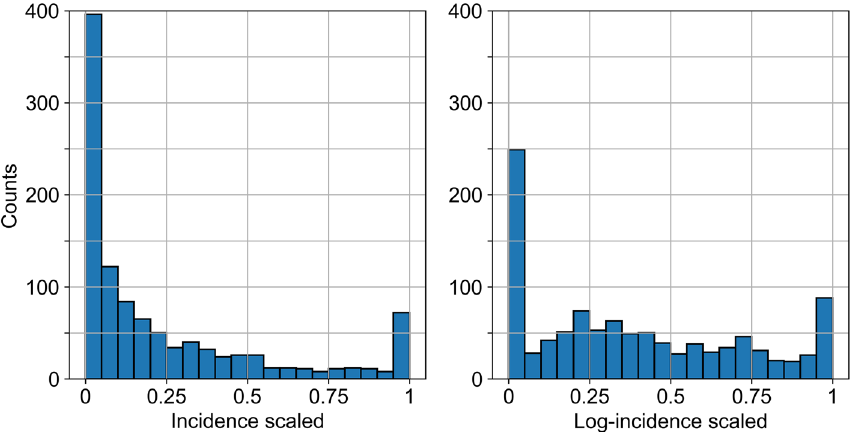
Figure 5. Histograms of the annual PUUV incidence from 2006 to 2021, scaled to its maximum value for each of the selected districts. Left: Raw incidence. Right: Log-transformed incidence, according to Eq.